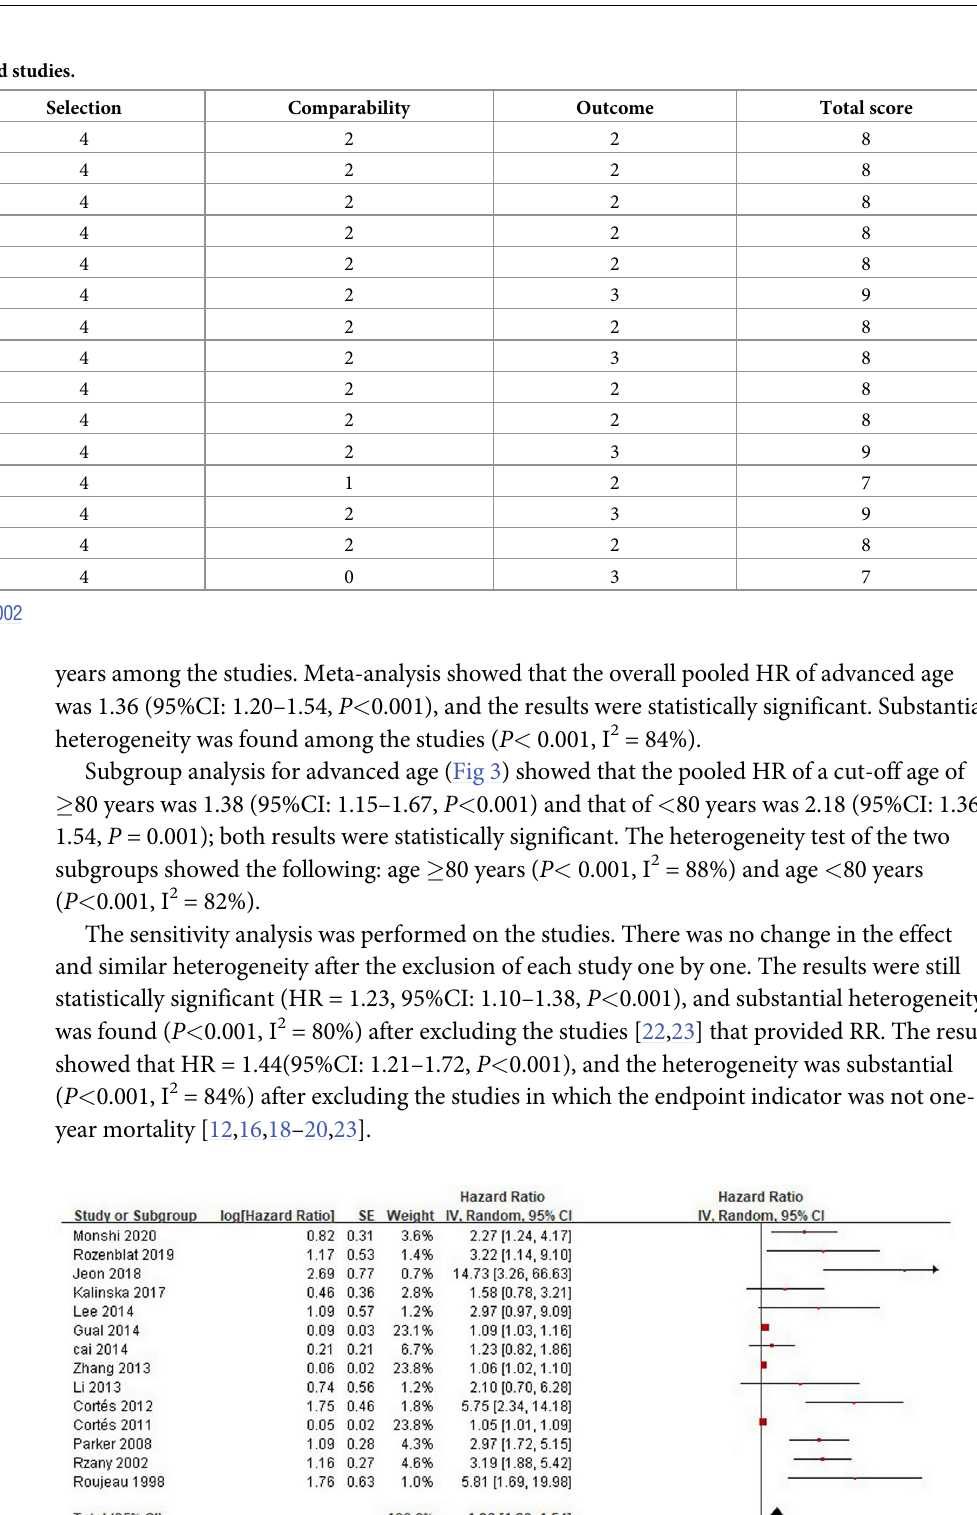
Fig 2. Forest plot of the association between advanced age and bullous pemphigoid